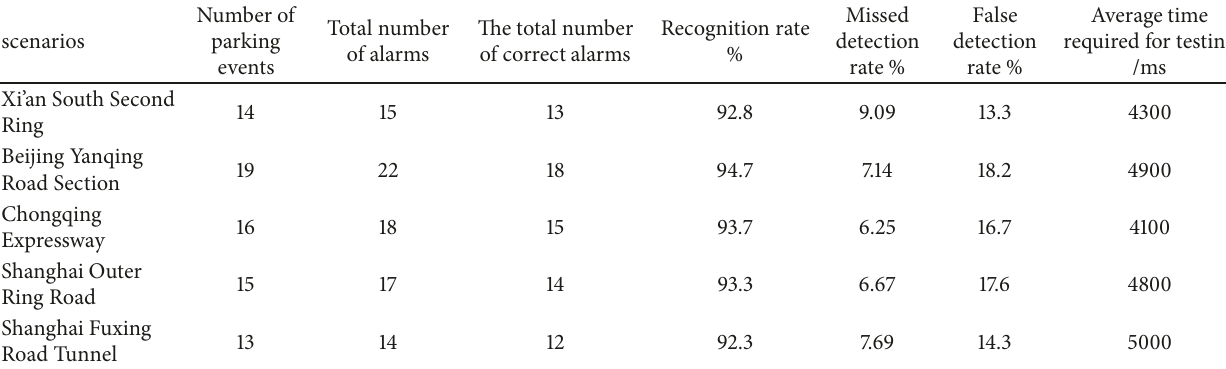
Table 3: Detection results of the falling objects in different